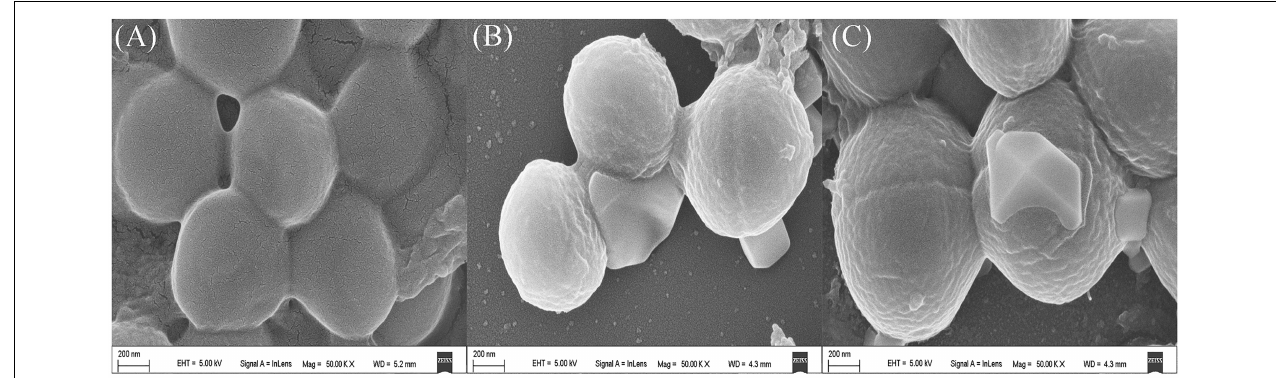
FIGURE 5 | Scanning electron microscopy (SEM) images of pure compounds treated and untreated MRSA (50,000 × ). (A) Untreated MRSA. (B) Actinomycin X 2 treated MRSA. (C) Collismycin A treated MRSA.